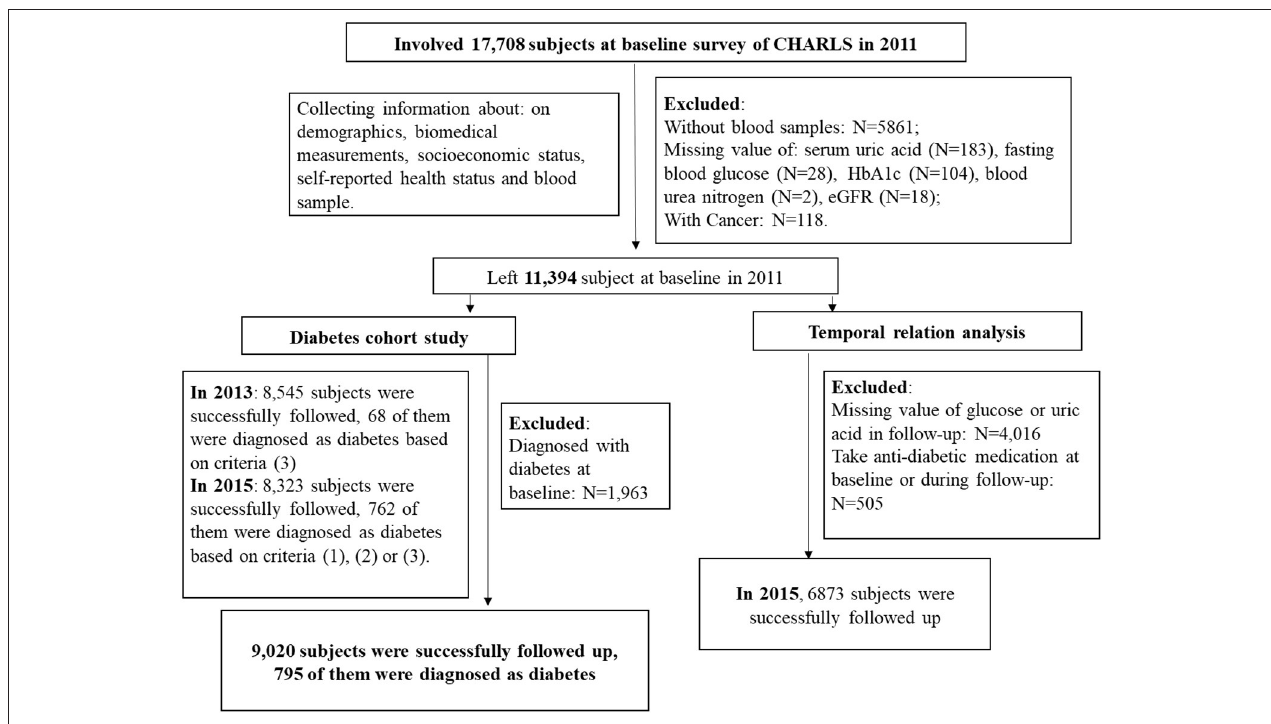
FIGURE 1 | Flow diagram of patients included in this